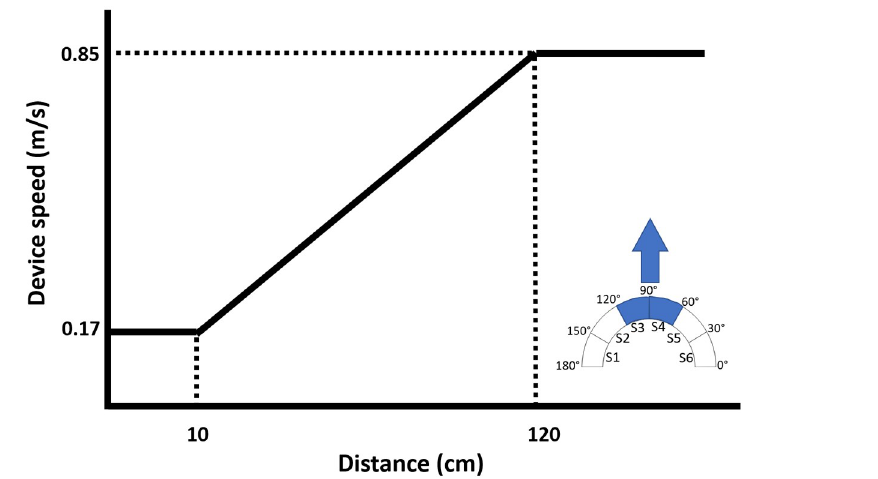
Fig 3. Distance-based speed control mapping for the speed of the